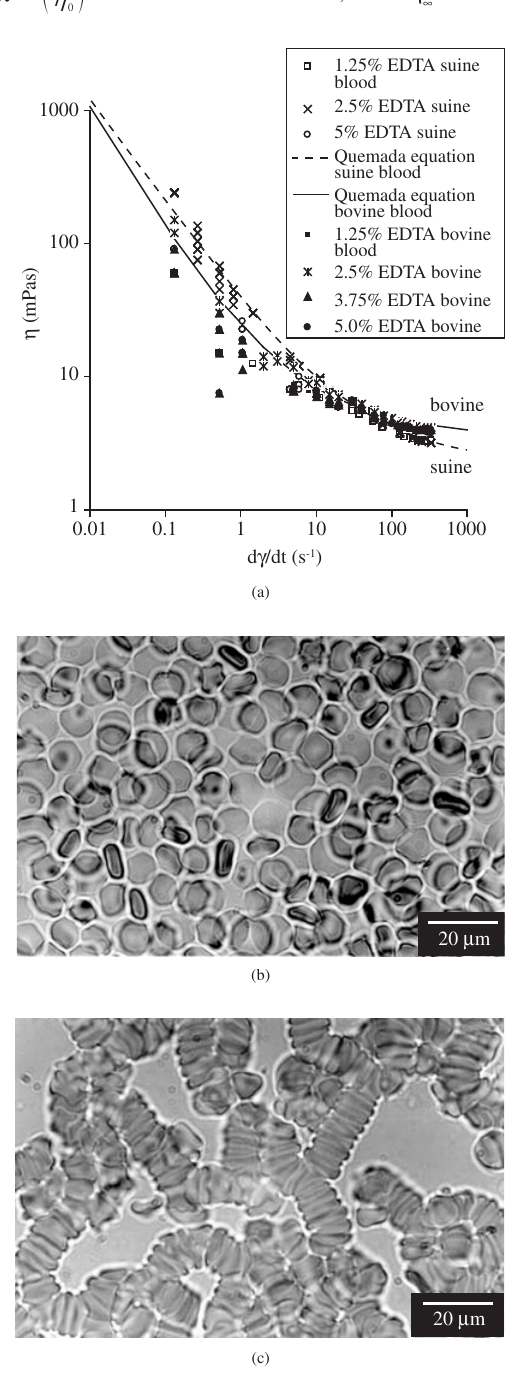
Figure 1. a) Viscosity of pig and bovine blood at 39 °C; b) bovine erythrocytes do not aggregate; and c) pig erythrocytes aggregate to form roleaux